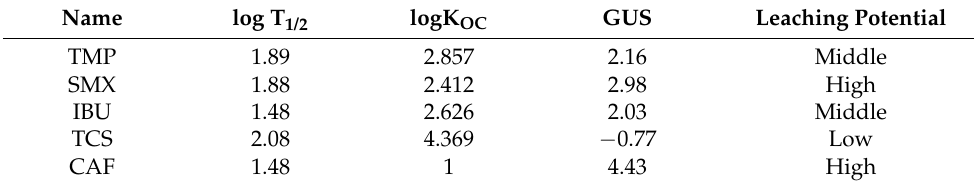
Table 3. The logT 1/2 , logK oc and GUS of PPCPs in